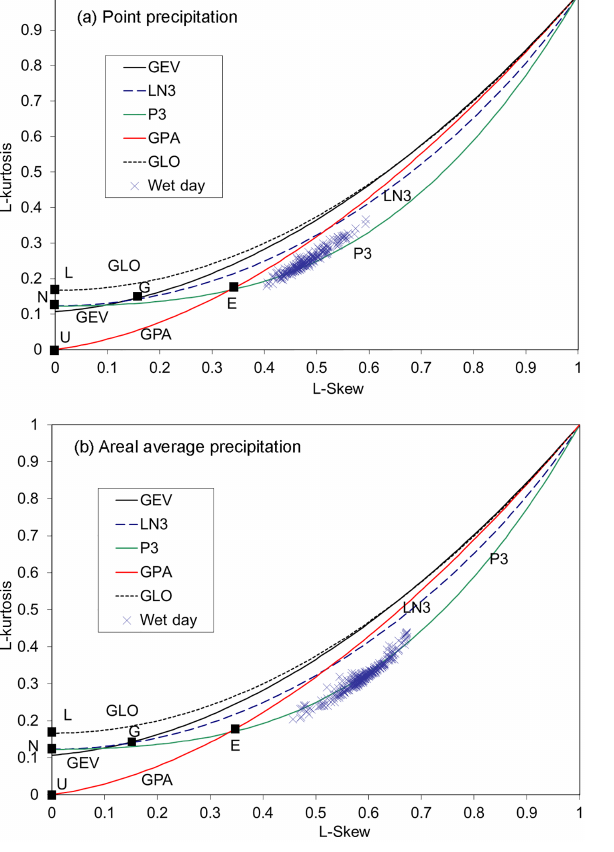
Figure 5. L-skew vs. L-kurtosis L-moment ratio diagram of sam- ple L-moments and theoretical distributions: (a) point precipitation and (b) areal average precipitation depths. Logistic ( L ), normal ( N ), uniform ( U ), Gumbel ( G ), and exponential ( E ) distributions appear as a single